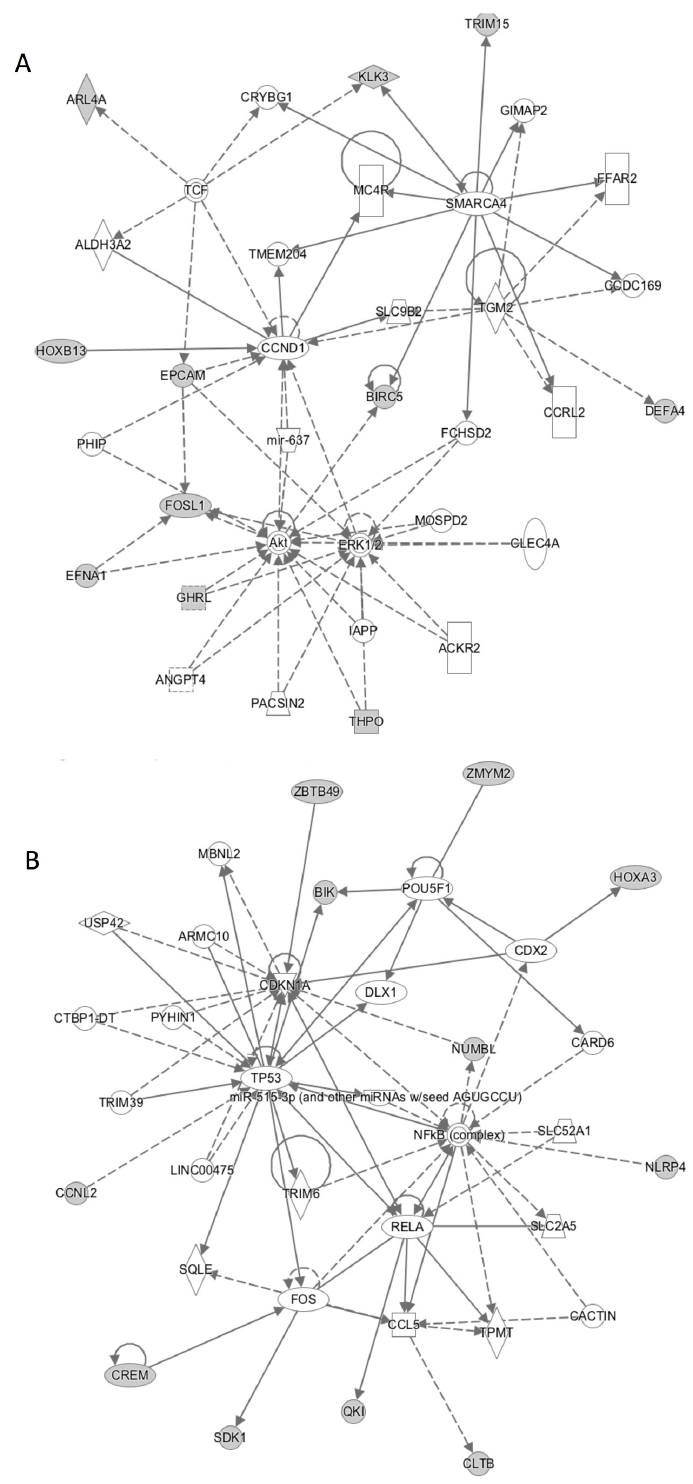
Figure 1. Two main molecular networks linked to the circulating tumor cell (CTC) profile identified after the global gene expression characterization. Network ( A ) has as central molecules TP53 and NFkB , while network ( B ) relays on AKT, ERK, and CCND1 .